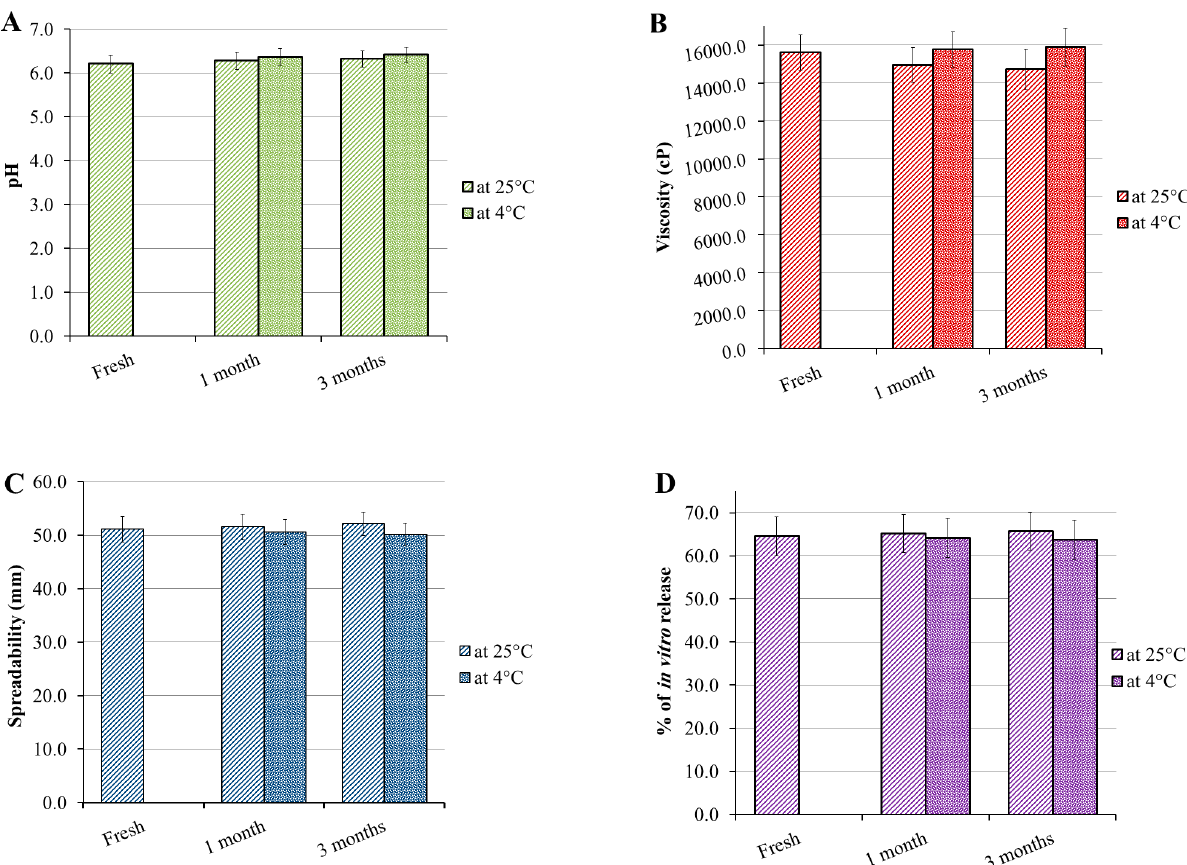
Figure 6. Graphs representing stability testing of FA-SLN-hydrogel following 1 and 3 months storage at 25 ± 2 °C and 4 ± 2 °C in terms of ( A ) pH, ( B ) viscosity, ( C ) spreadability and ( D ) in vitro study when compared with fresh formulation.